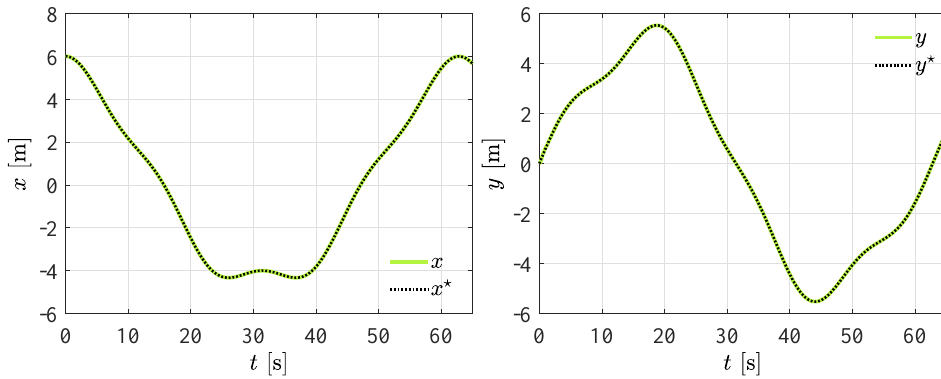
Figure 16. Translational motion tracking for experiment 4.